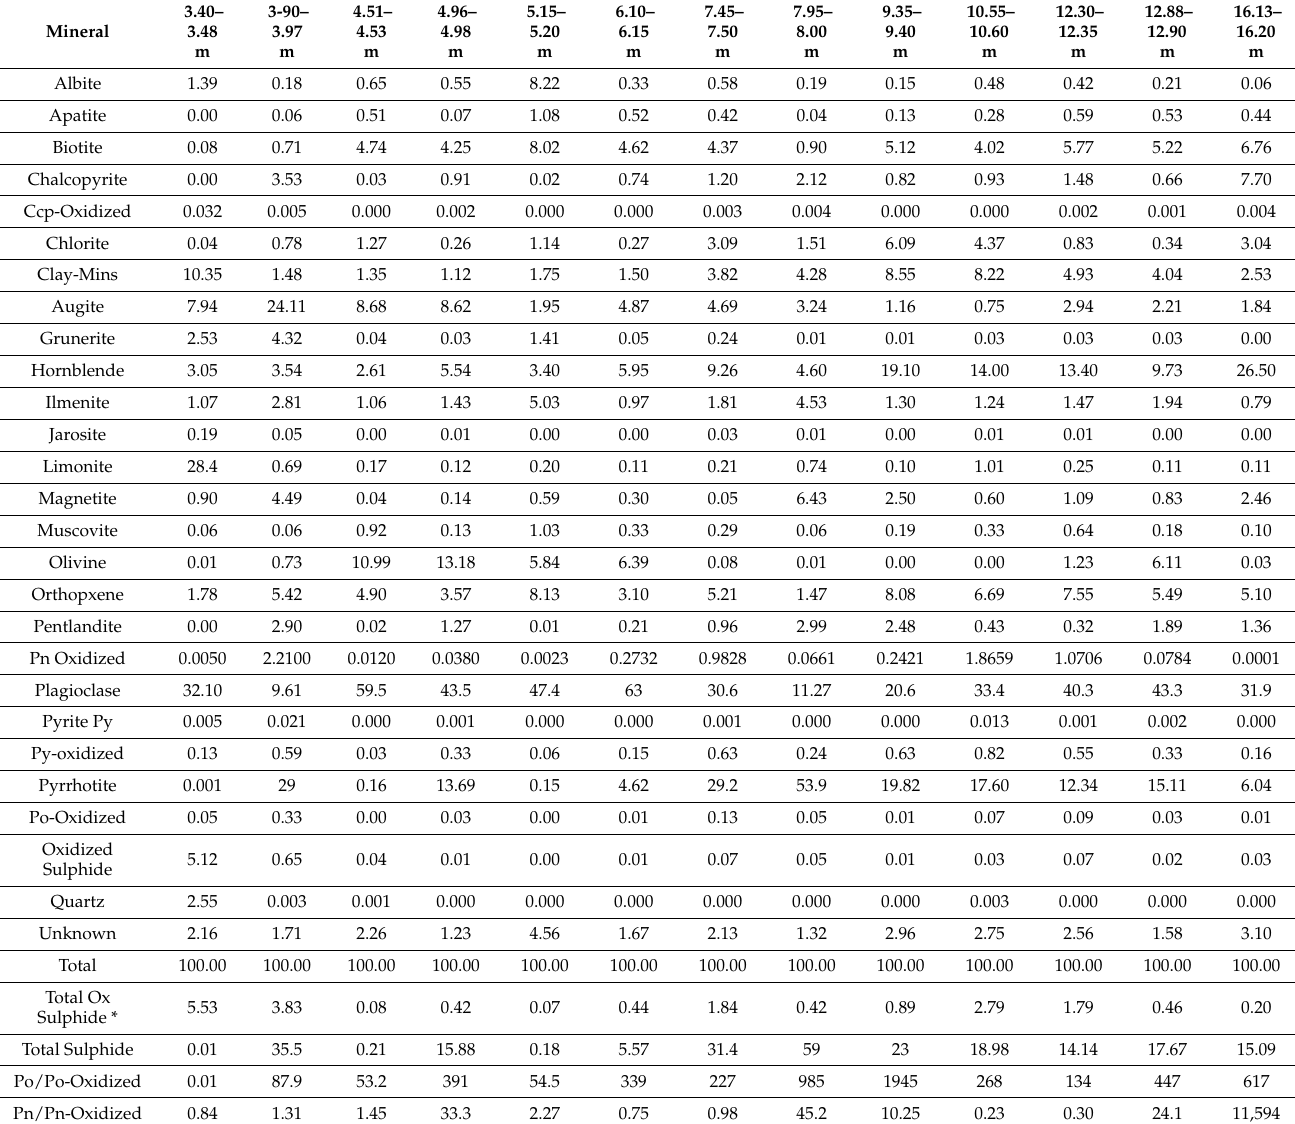
Table 1. MLA-SEM mineral data for hole VB95-129 (area %). * Total Ox Sulphide is total of all oxidized sulphide